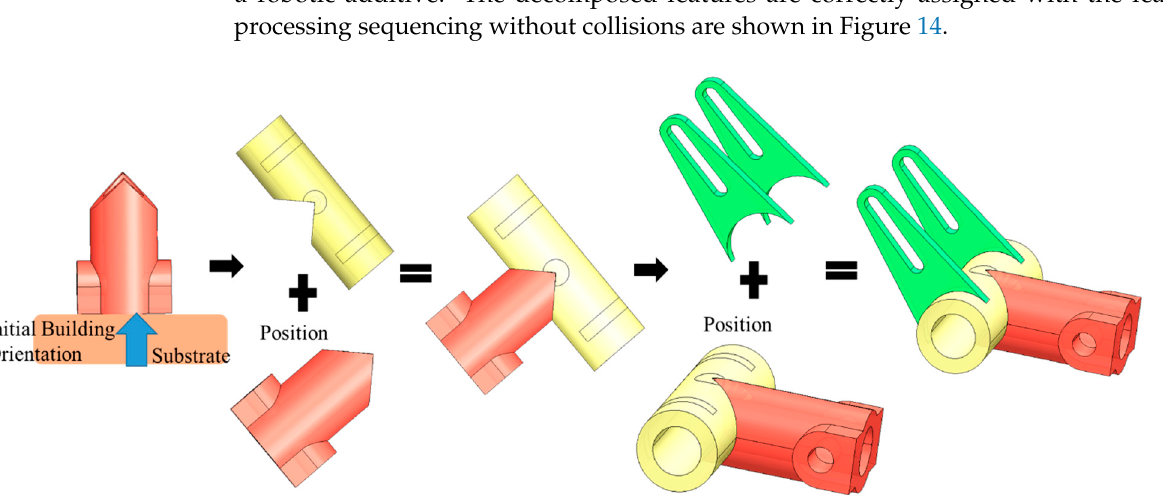
Figure 13. Trajectory accumulation on model with second defined initial building orientation for model (a).